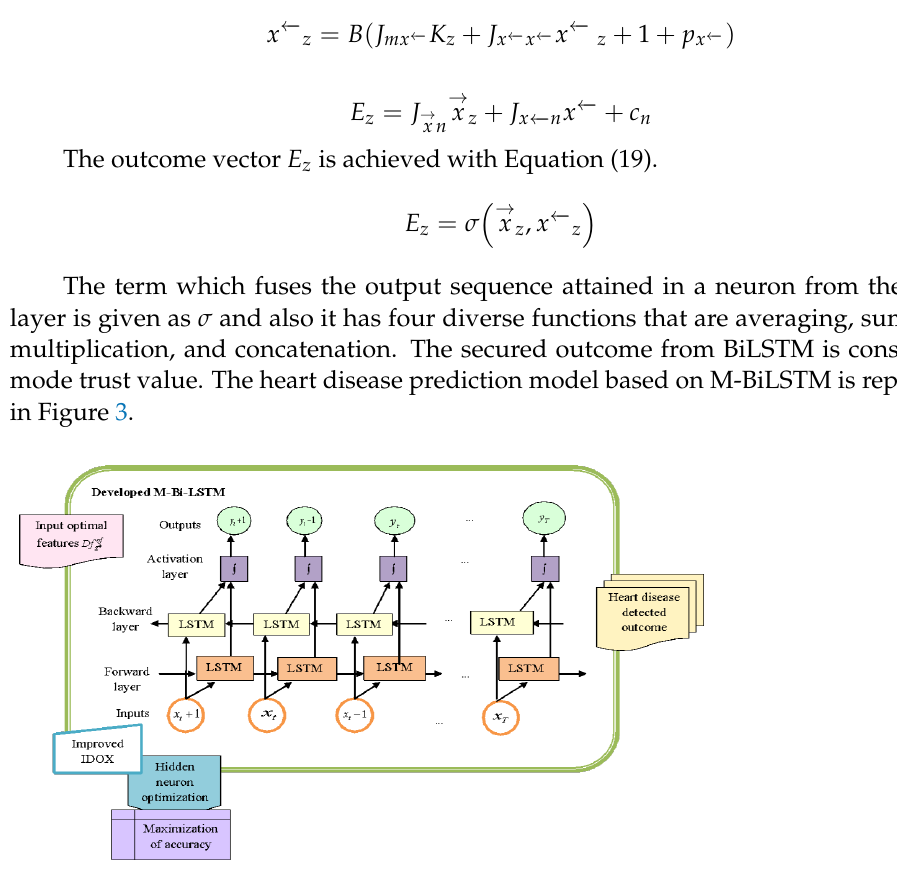
Figure 3. Heart disease prediction model based on the developed M-BiLSTM.